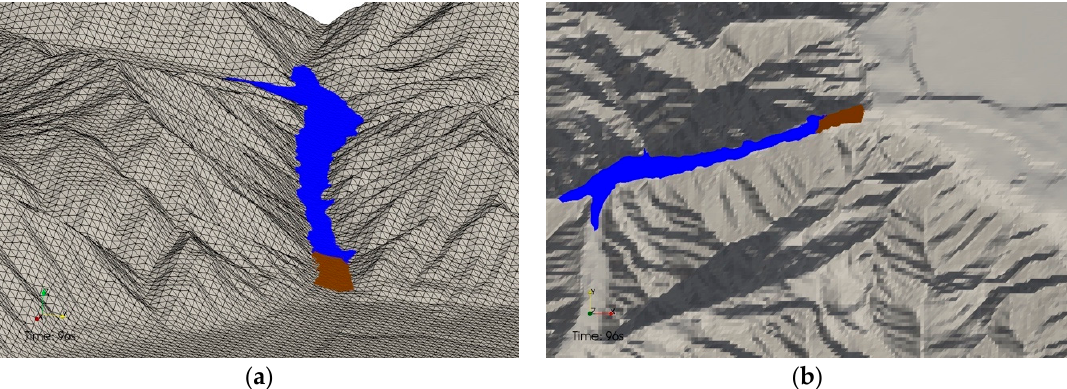
Figure 6. Demonstrative test case for the meshless SPH method applied to a 3D erosional dam-break flood on complex topography [8]. ( a ) 3D view. ( b ) Top view. Digital elevation model (grey, with a black vertex triangulation), liquid SPH particles (blue), mixture SPH particles (brown).